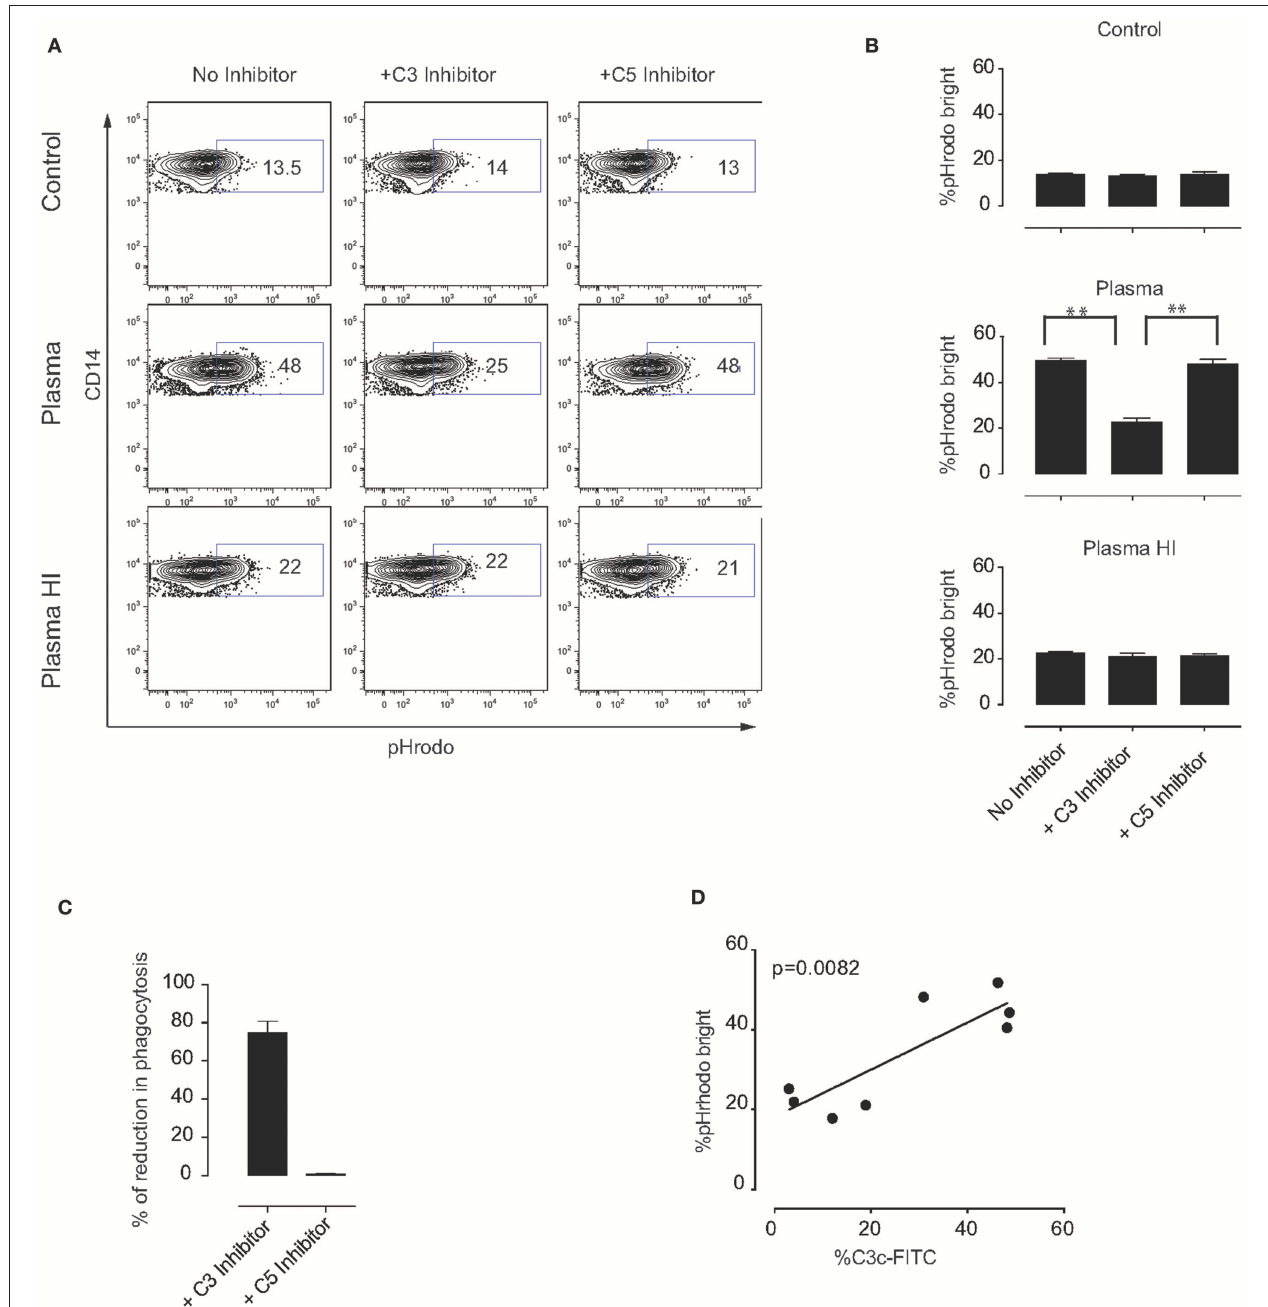
FIGURE 5 | Mechanism of MSC phagocytosis by monocytes. MSC were labeled with pHrodo and incubated with or without active plasma for 1h in the presence or absence of the C3 inhibitor compstatin or the C5 inhibitor soliris. Cells were washed and co-cultured with PBMC for 2h. (A) Representative plots of flow-cytometric analysis of phagocytosis by monocytes. pHrodo bright fluorescence indicates cells that have phagocytosed labeled MSC. (B) Pooled data from two independent experiments using a total of four different MSC. Bars represent mean values with SD ( n = 4). Statistical significance was determined using ANOVA followed by Holm-Sidak’s multiple comparisons test ** p = 0.001. (C) Percentage of reduction in phagocytosis in the presence of C3 or C5 inhibitor calculated from the data shown in (B) and the percentage of phagocytosis observed in plasma free medium was subtracted. (D) Correlation between percentage of C3b/iC3b binding to MSC and percentage of pHrodo bright monocytes from HI plasma and plasma in the phagocytosis experiments.